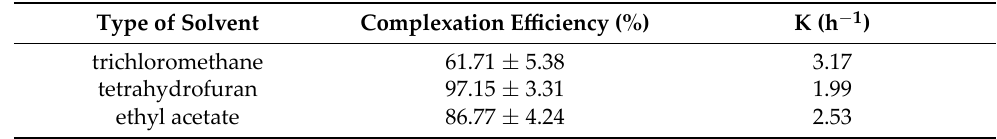
Table 3. Complexation efficiency and dissociation rate of GTP‑PC of different types of solvent. Type of